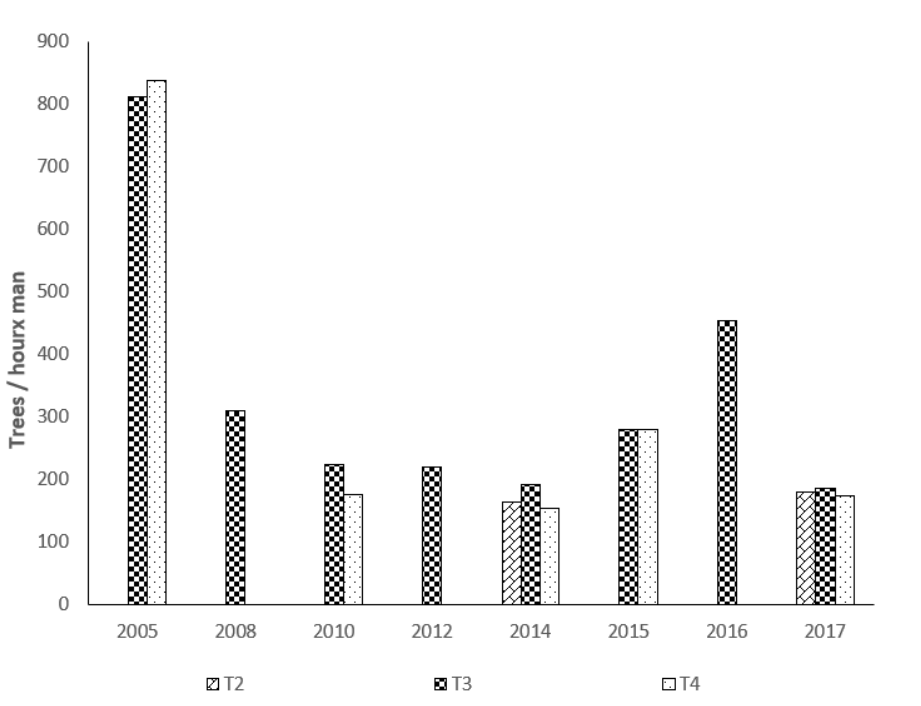
Figure 4. Average work rates (trees/hour × man) by treatment with the disk-saw pruning machine: T2 — treatment 2; T2 — treatment 3; T4 — treatment 4. T2—treatment 2; T2—treatment 3; T4—treatment 4.